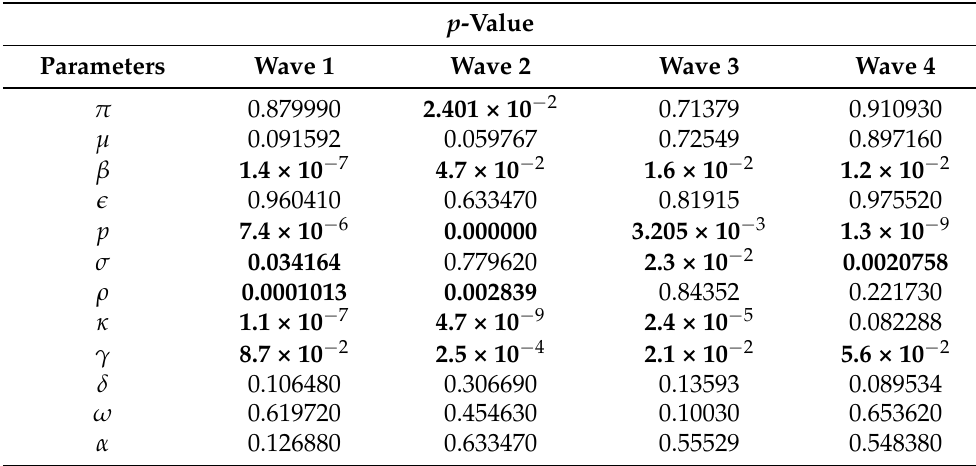
Table 3. Output from PRCC analysis.